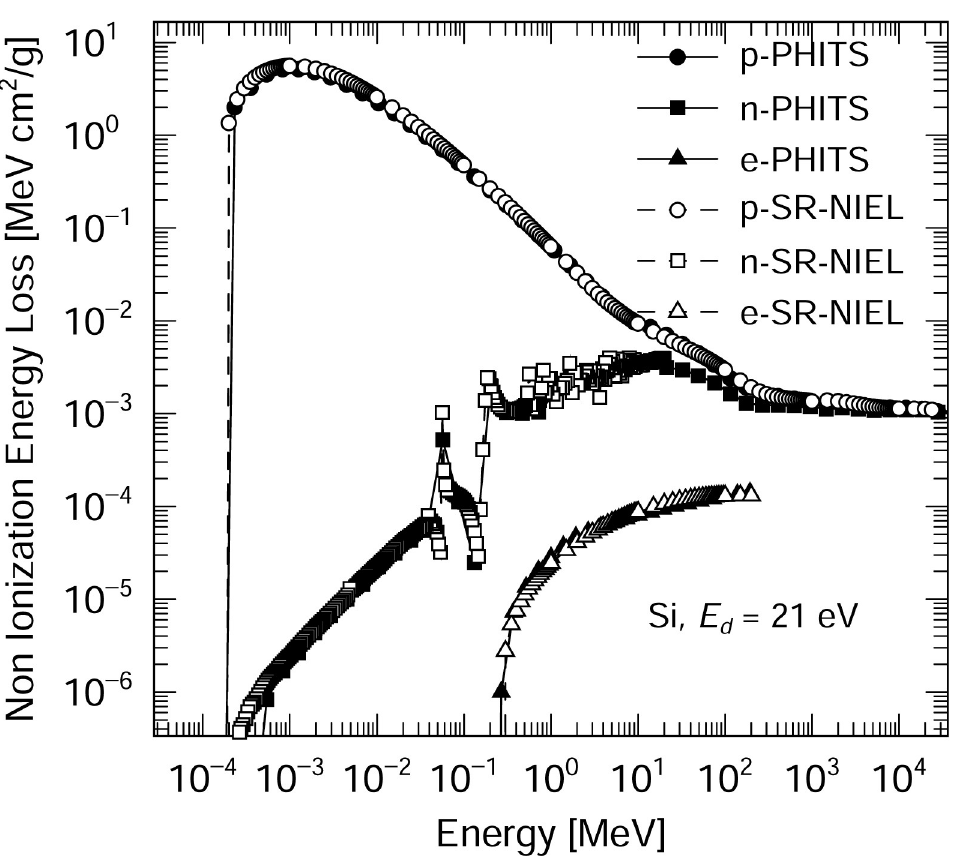
Fig 1. NIEL values for the proton, neutron and electron irradiation of silicon. This plot confirms that the NIEL values calculated using the PHITS model were in good agreement with the data obtained from the SR-calculator [12].